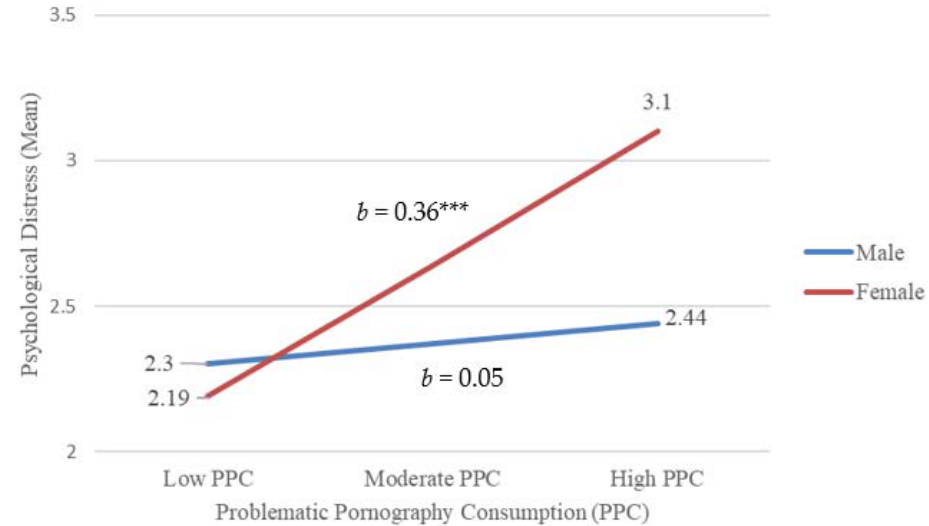
Figure 1. Interaction between problematic internet pornography use and gender in predicting psychological distress ( n = 144). Note: *** p < 0.001.